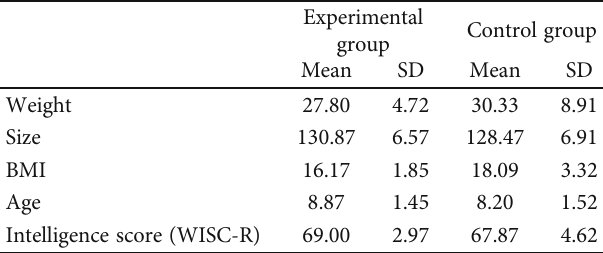
Table 1: Characteristics of the individuals who participated in the